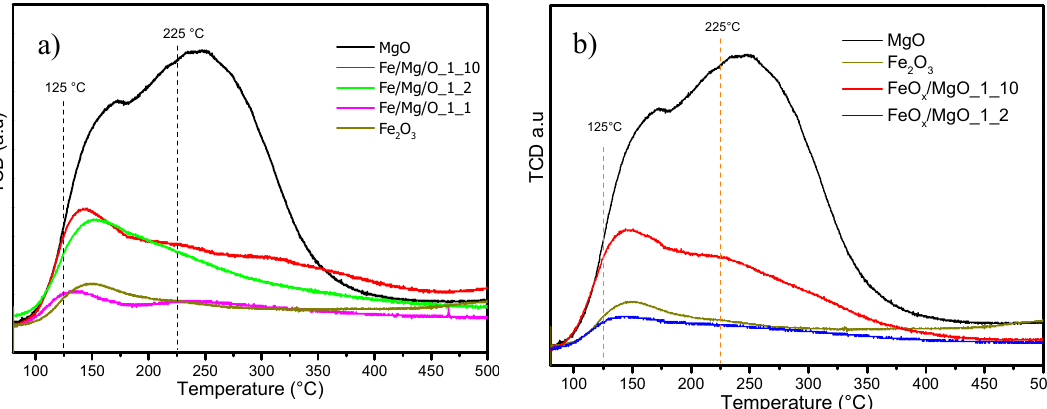
Figure 2. CO 2 -TPD curves of: ( a ) coprecipitated Fe/Mg/O samples, MgO, and Fe 2 O 3 ; and ( b ) impregnated FeO x /MgO samples, MgO, and Fe 2 O 3 .